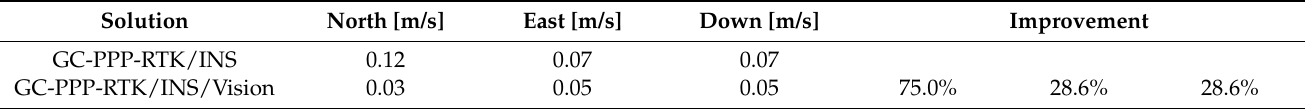
Table 7. RMS of the velocity error of T02 in north, east, and down directions,